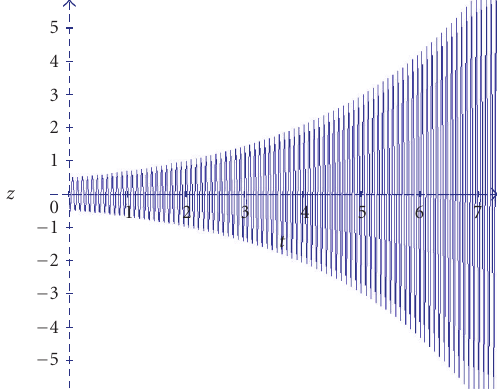
Figure 6.5 . Unstable solution of (5.2) in the point D (544 . 5,46), a 0 = 0 . 4.